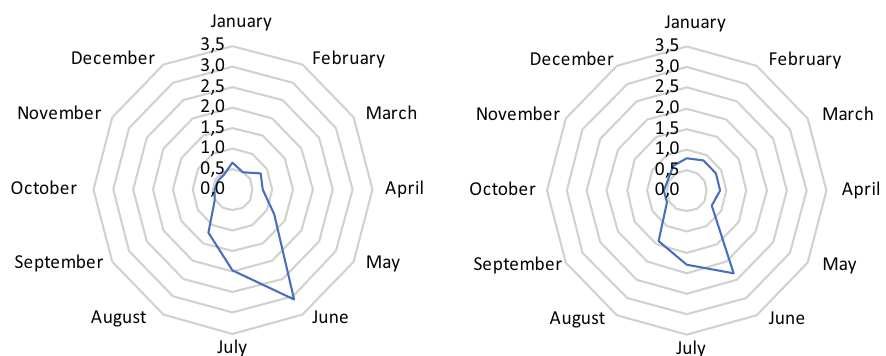
Figure 1. Seasonal indices of infant mortality (left) and child mortality (right) in the Pokrovsky parish (1877-1897), both sexes. Source: author’s calculations based on parish registers.